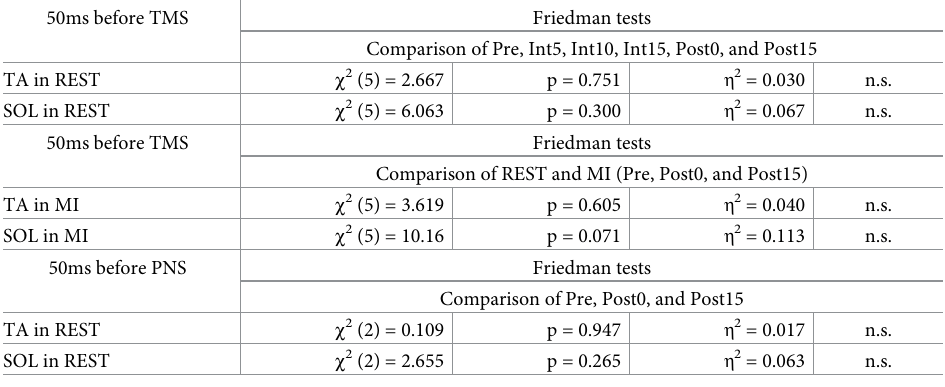
Table 6. Test statistic values, p-values, effect sizes of Friedman tests for the normalized background EMG activity (% of MVC) in the TA and SOL muscles, 50 ms before TMS and PNS. 50ms before TMS Friedman tests Comparison of Pre, Int5, Int10, Int15, Post0, and Post15